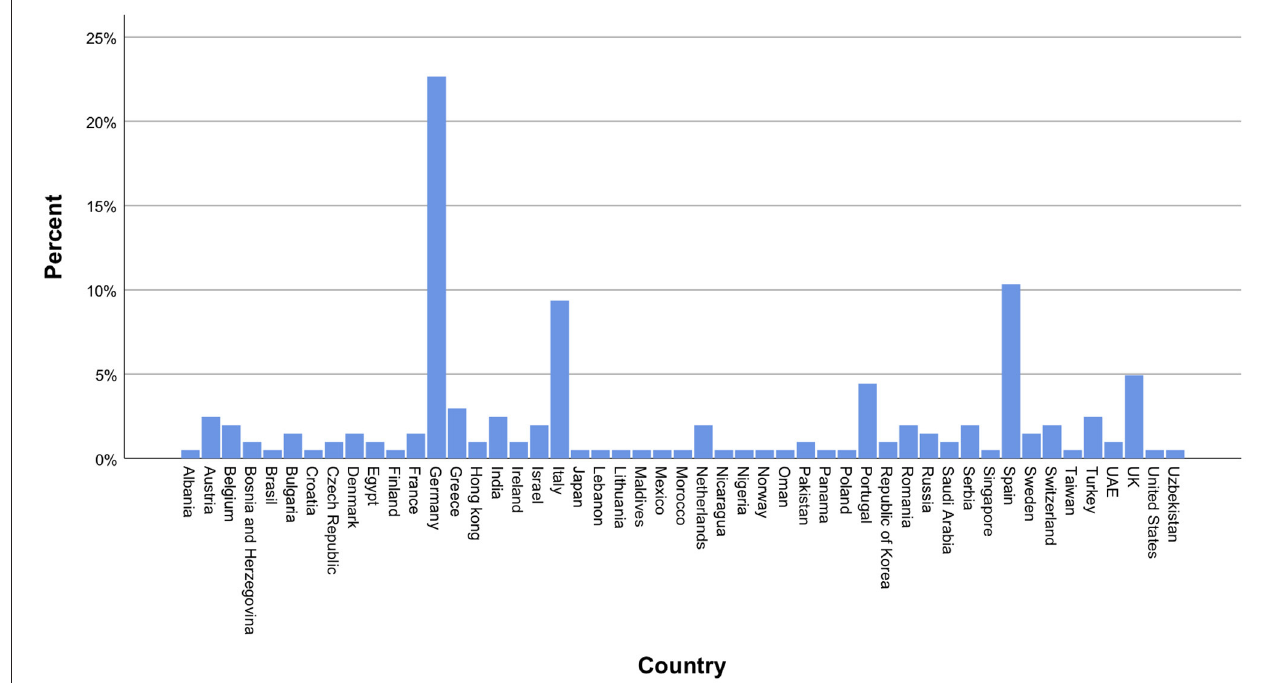
FIGURE 1 | International distribution of participating neurosurgeons. The majority of participants were from Germany, Spain, Italy and the United Kingdom.